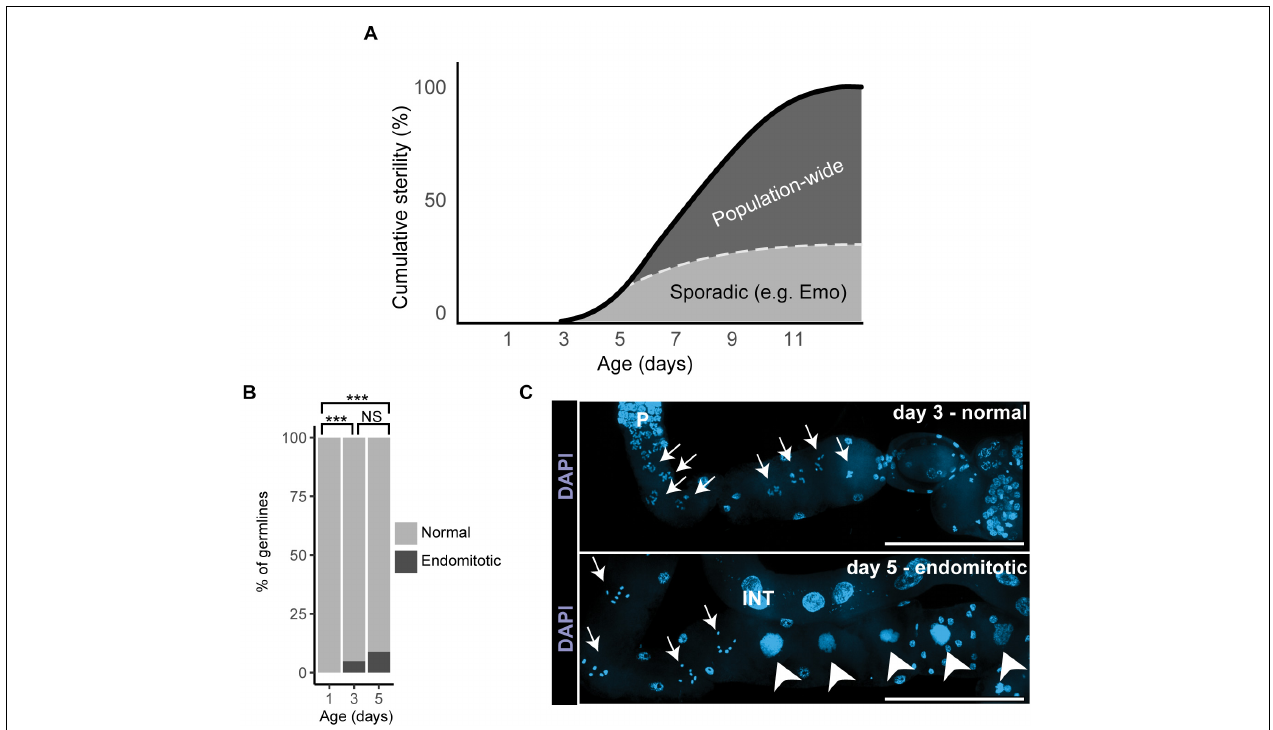
FIGURE 5 | Sporadic degenerative changes in the aging germ line. (A) The graph illustrates how sporadic and population-wide changes contribute to cumulative age-related sterility in mated wild-type hermaphrodites. Endomitotic oocytes or shifted distal tip cells are sporadic degenerative changes and account for less than half of age-related sterility (the dotted line indicates a model of the relative contribution of sporadic defects). Declines in stem cell number and activity, PZ and germ line shrinking, as well as slower cell cycles are population-wide changes that appear to be the main drivers of reproductive aging. Adapted from Kocsisova et al. (2019). (B) Analysis of sporadic changes in day 1, 3, and 5 mated wild-type hermaphrodites: Percentage of dissected germ lines with (black) or without (gray) endomitotic oocytes (black). Adapted from Kocsisova et al. (2019). (C) Representative fluorescence micrographs of wild-type mated hermaphrodites stained with the DNA-dye DAPI. Oocytes of a day 3 adult show normal chromosomes in diakinesis (arrows in top panel) in contrast to endomitotic oocytes (arrowheads in lower panel) of a day 5 adult. P, pachytene; INT, intestine. Scale bars: 100 µ m. Adapted from Kocsisova et al.